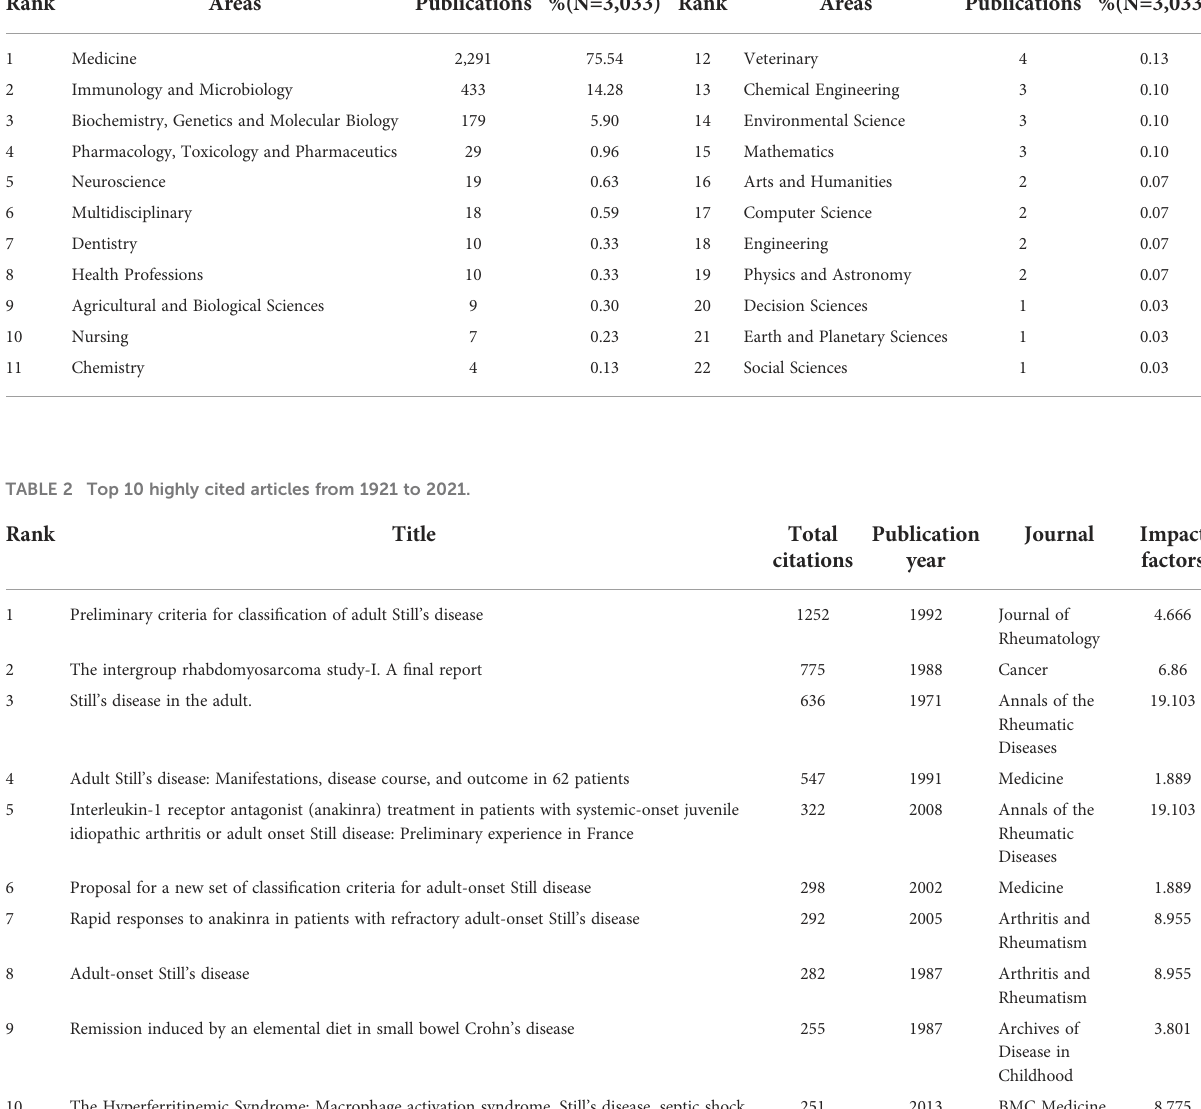
TABLE 1 The research areas of adult-onset Still ’ s disease articles from 1921 to 2021.